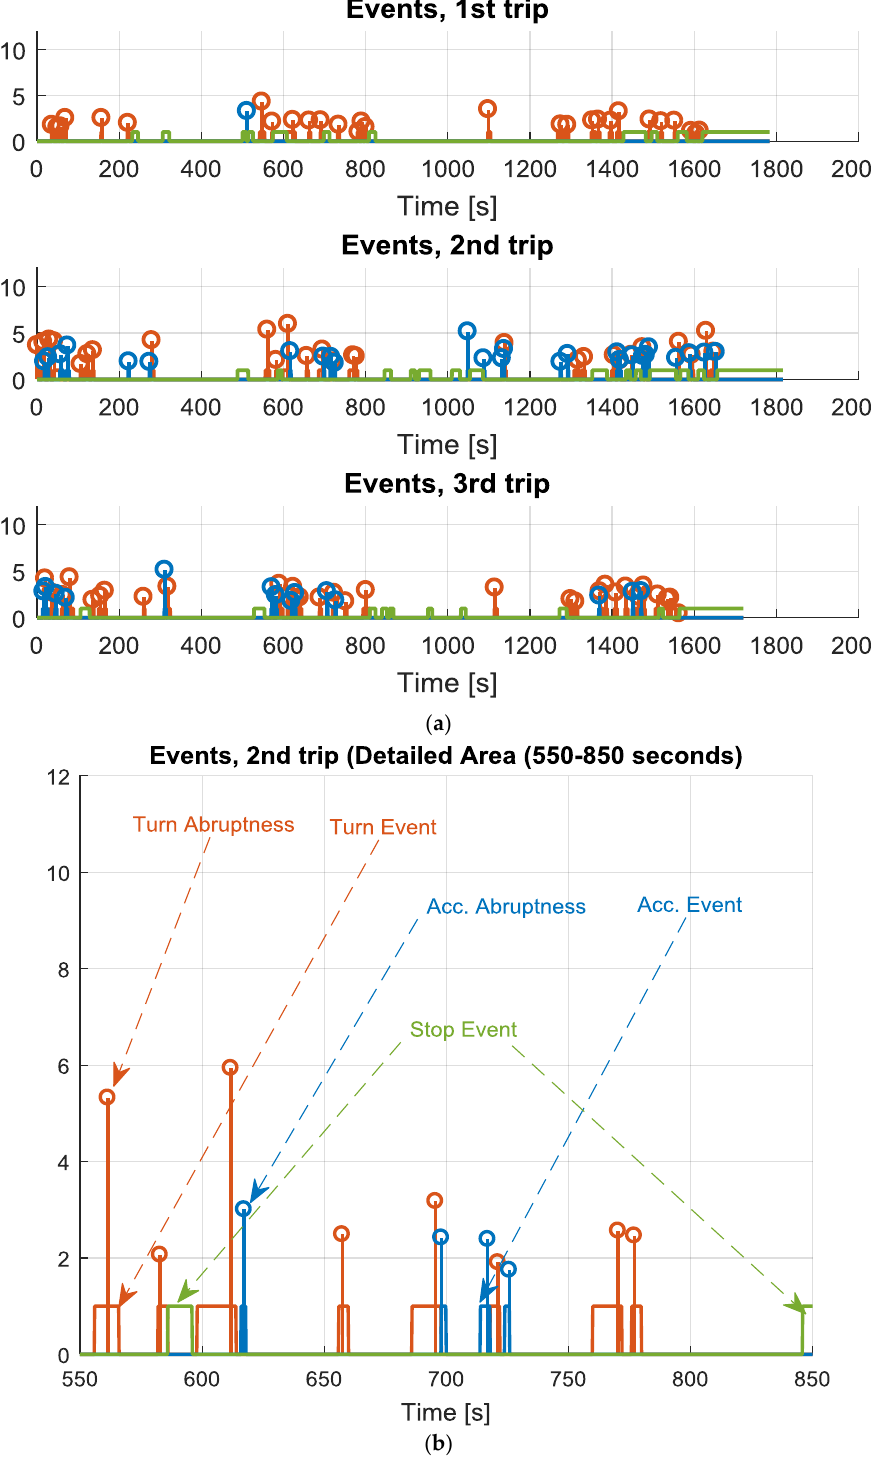
Figure 9. ( a ) Detected events of the three representative trips. ( b ) Zoom over an area with events.